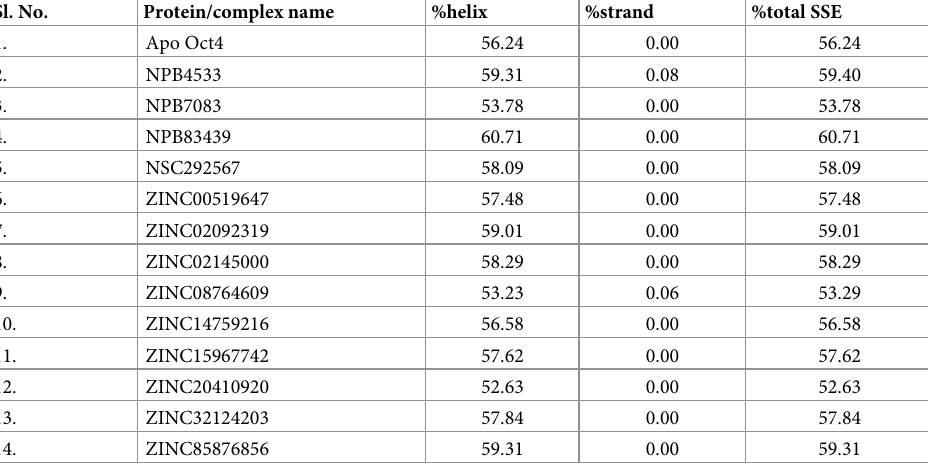
Table 5. Showing the ratio of secondary structure elements distributed by the protein throughout the simulation. Sl.